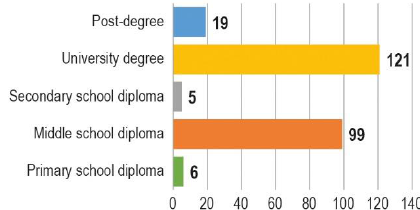
Figure 2. Educational level of the respondents who consider community-owned dogs (CODs) an effective measure to control stray dog populations ( n = 250).